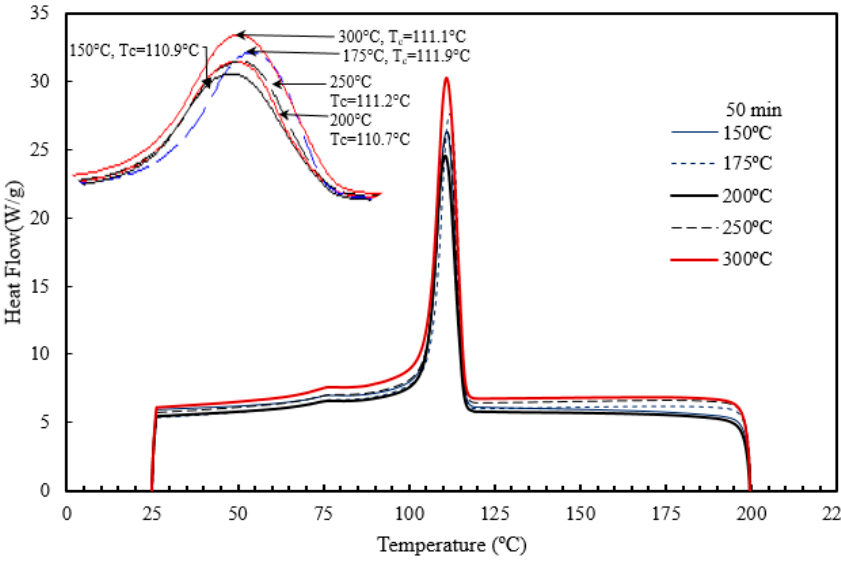
Figure 17. Effect of barrel temperature on the crystallization temperature of the injection molded HDPE/TiO 2 nanocomposites.